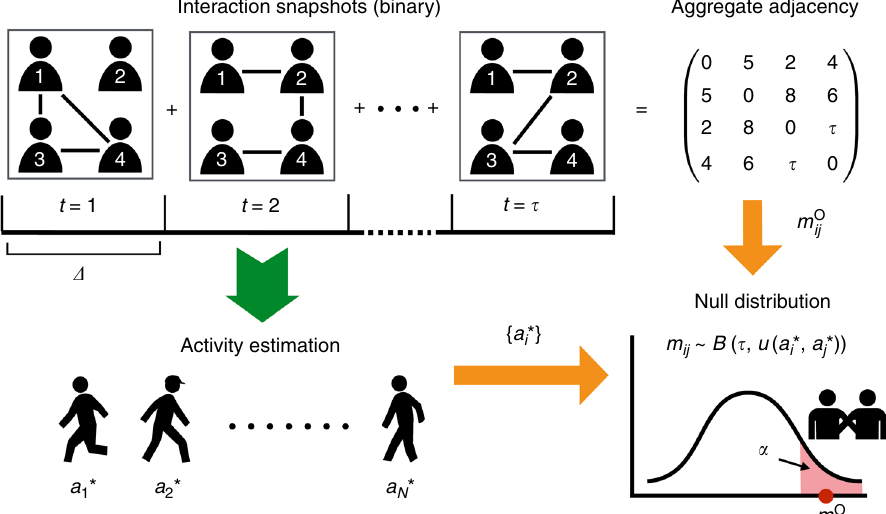
Fig. 1 Sketch of the fi ltering method. From the temporal network at resolution Δ , described by τ = T / Δ adjacency matrices, we estimate the set of node ; ¼ ; a (cid:2) activities ð a (cid:2) N Þ , and thus the probability distribution of the number of interactions between any pair of nodes ( 1 the empirical value m o ij with the percentiles of this distribution to determine the signi fi cance of the pair ( i , j ) ’ s